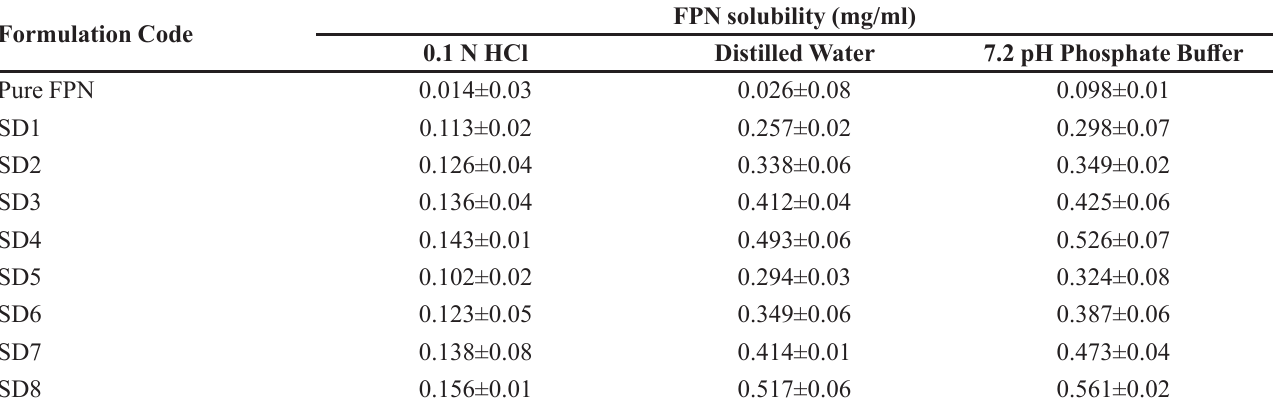
TABLE IV- Solubility of FPN and its SDs (Mean ± SD; n=6) Formulation Code